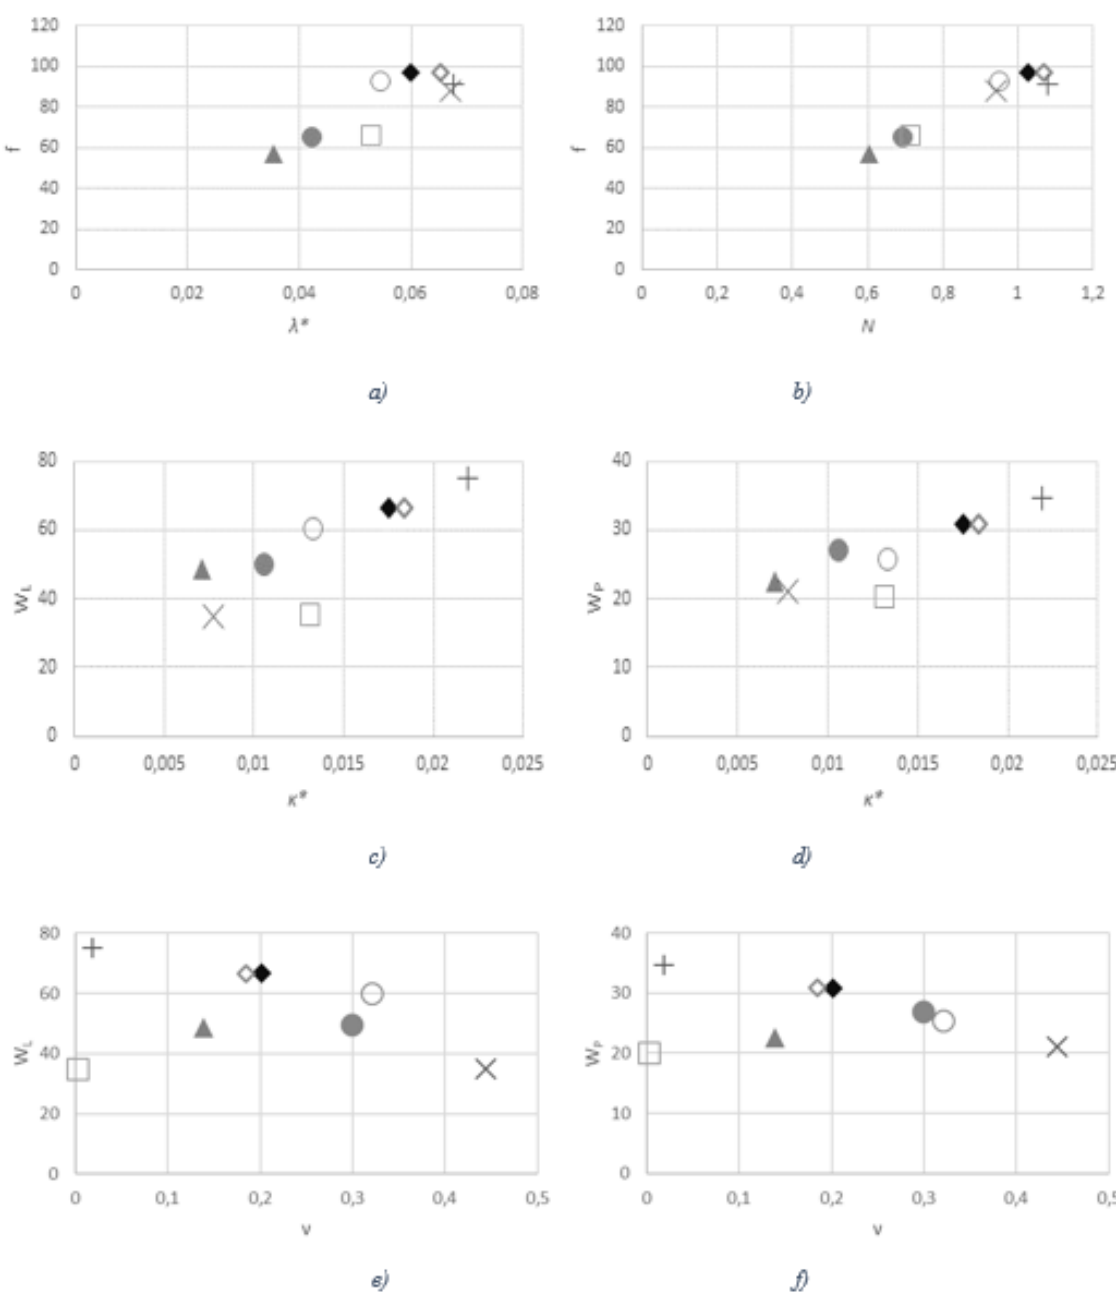
Figure 5. Correlations between HC parameters and index